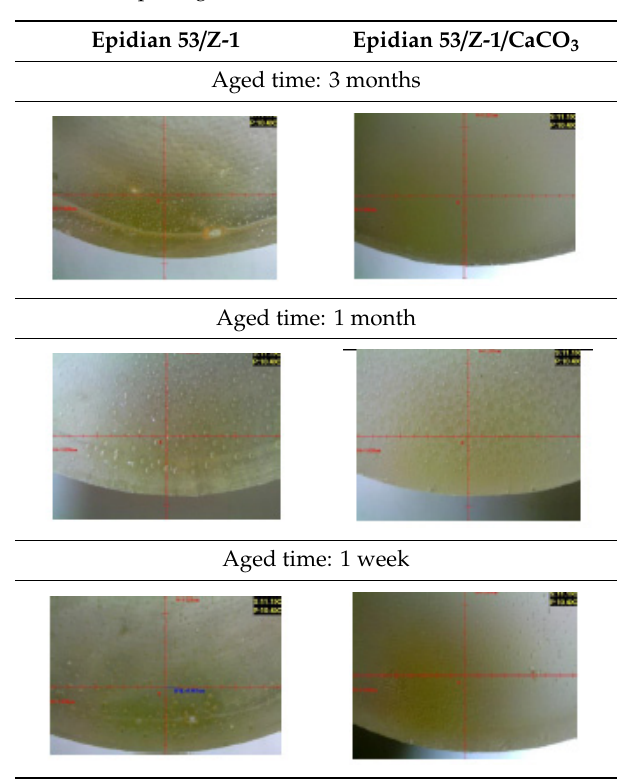
Table 6. Samples aged in the reference seawater environment.